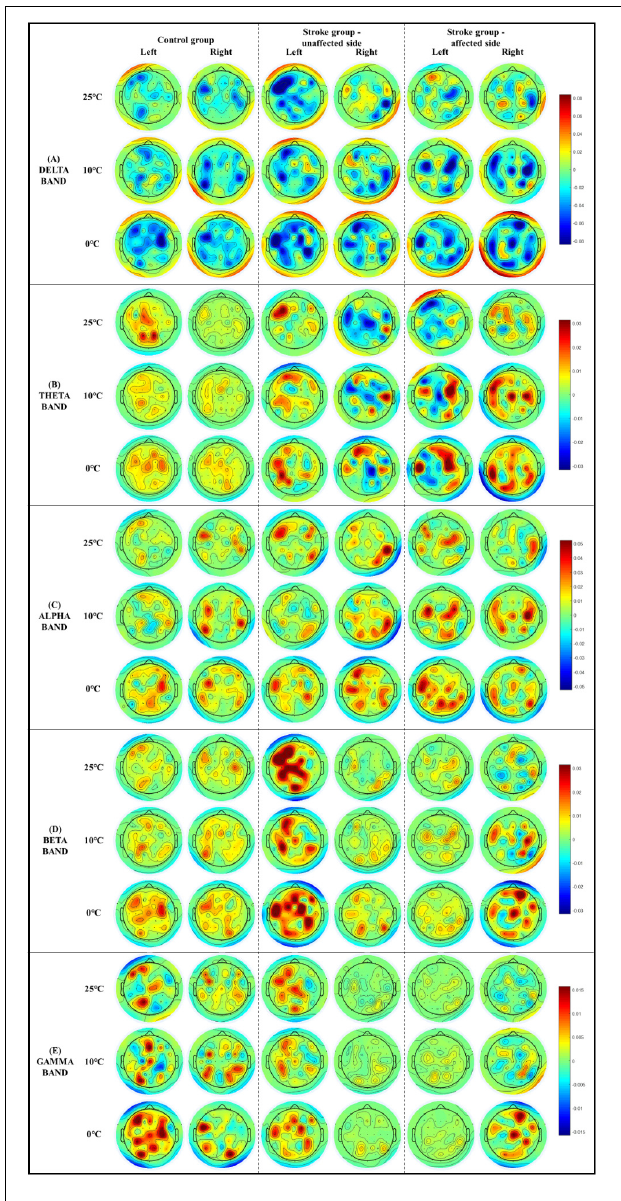
FIGURE 5 | The whole brain EEG topography on the mean relative spectral power of (A) delta, (B) theta, (C) alpha, (D) beta, (E) gamma in response to the non-painful cold stimuli with respect to the stimulation